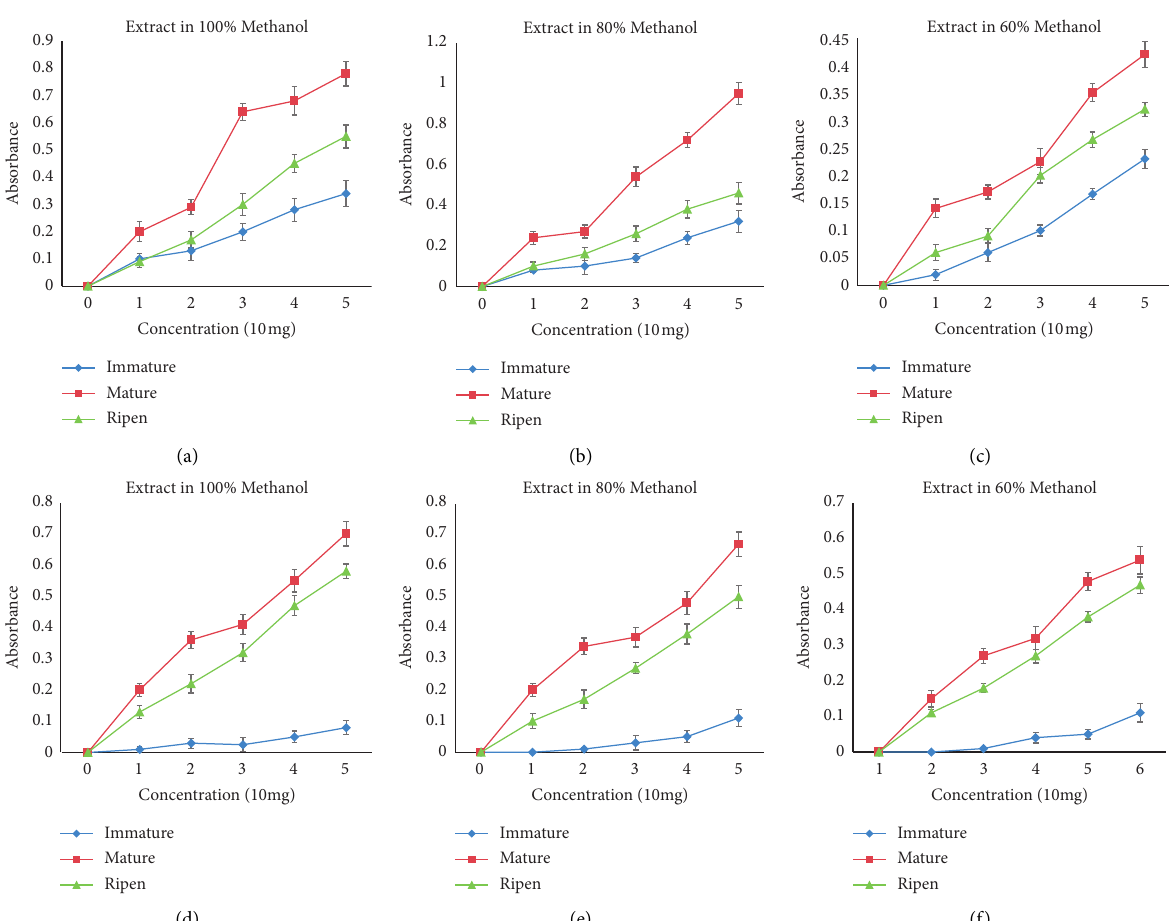
Figure 3: Antioxidant activities of immature, mature, and ripen BG extracts in 60%, 80%, and 100% methanol solvents on ferricyanide reducing power (a, b, c) and ferric reducing antioxidant power (d, e, f). Each value is expressed in terms of mean absorbance ( n � 3) ± standard deviation.